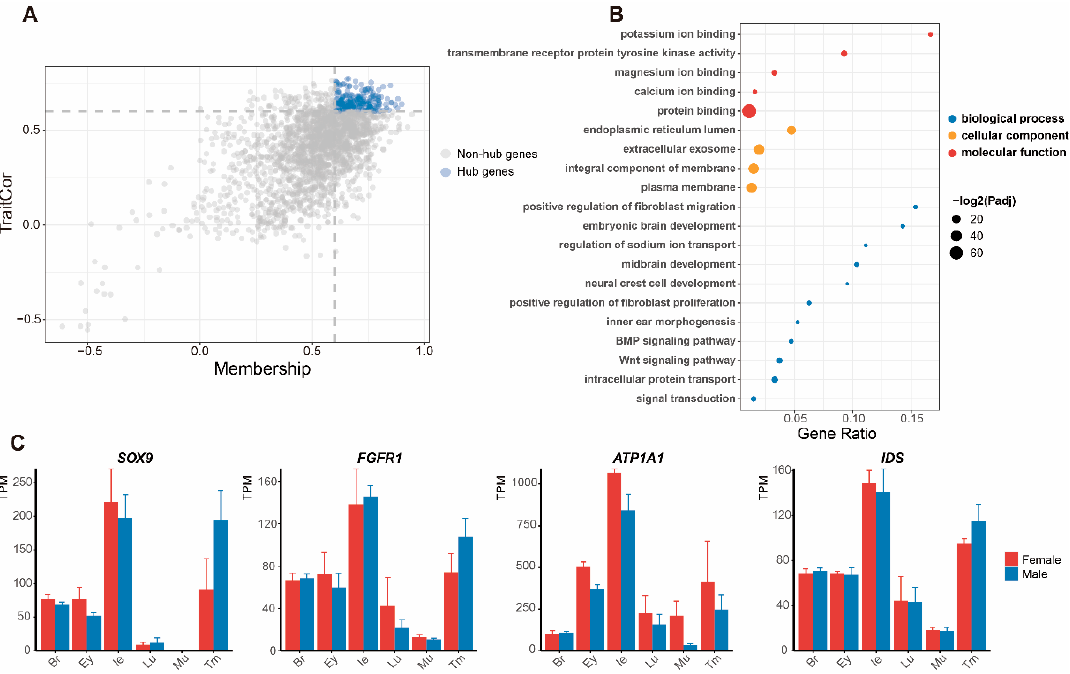
Figure 3. Screening and analysis of module genes associated with the inner ear. ( A ) Selection of hub genes in the dot plot. ( B ) Main Gene Ontology (GO) functional items enriched based on hub genes (Padj = corrected p -value). ( C ) Expression patterns of four featured genes in the six tissues. In the gene module of the tympanic membrane, 228 hub genes (GS > 0.5, MM > 0.5) were selected (Figure 4A). GO terms belonging to biological processes included signaling